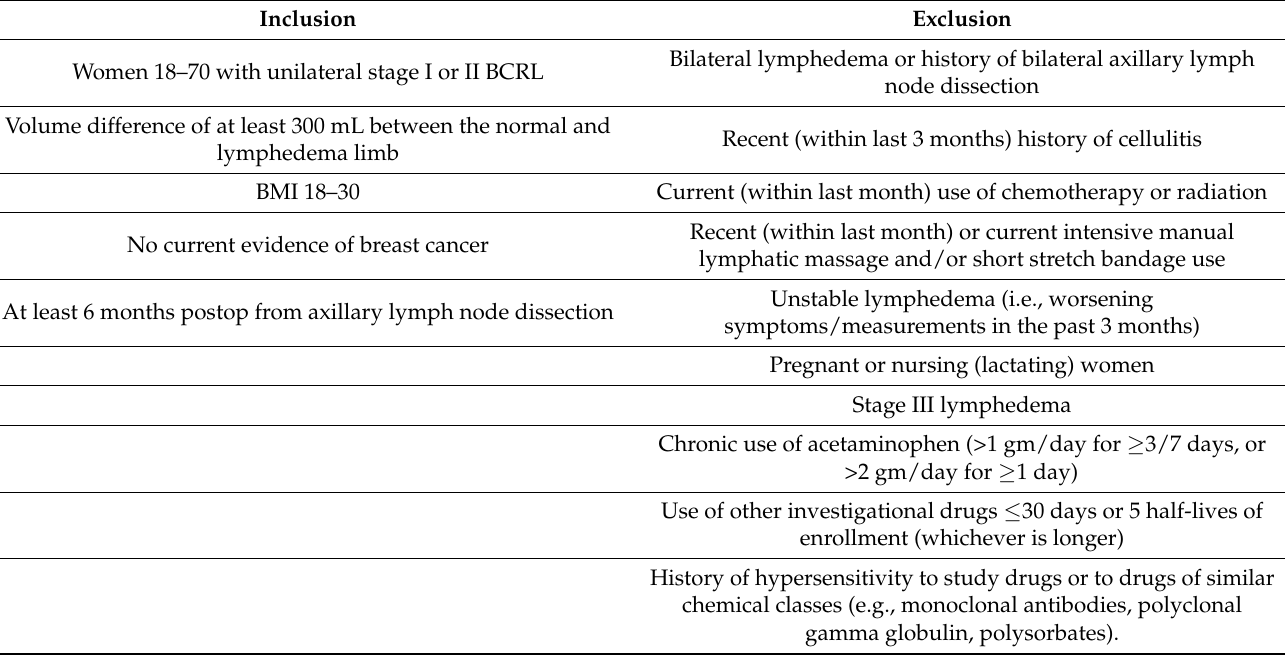
Table 1. Inclusion and exclusion criteria.